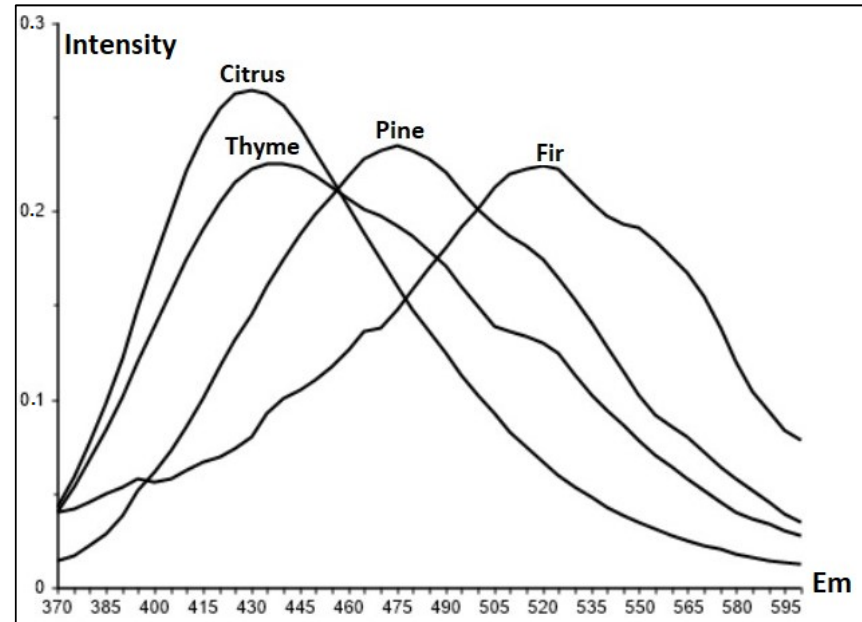
Figure 6. Emission spectrum at λ ex 330 nm.